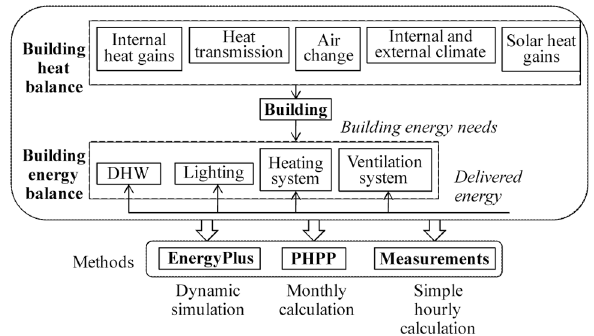
Fig. 2. Flowchart of evaluation of house heat and energy balance